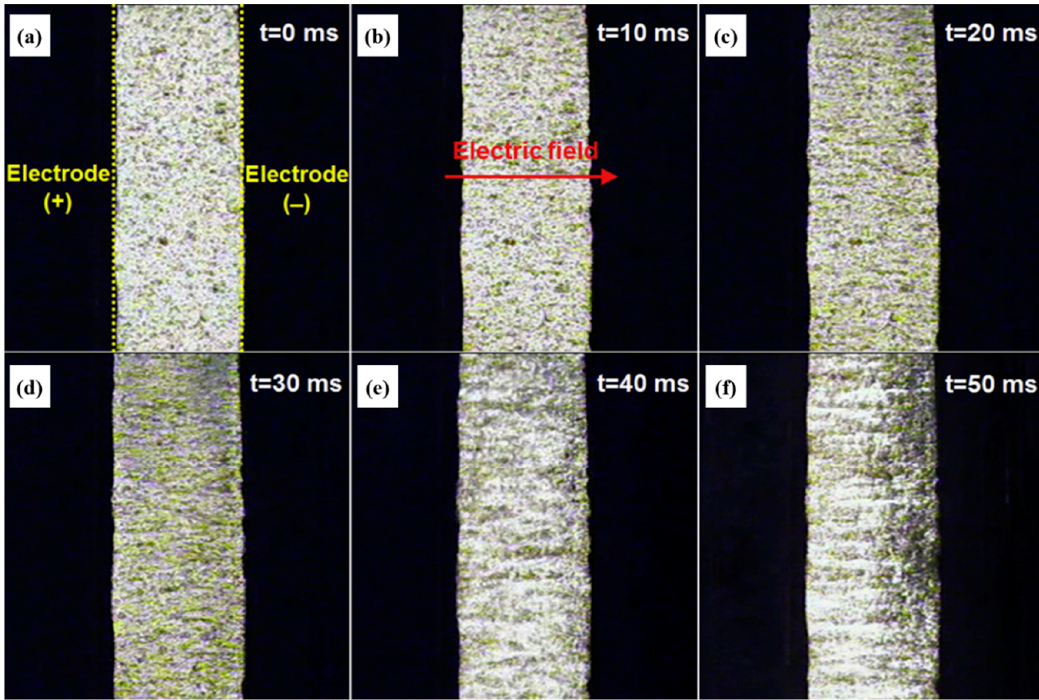
Figure 9. Optical microscope images of PANI/PSS-coated silica spheres dispersed in silicone oil (30 vol %) under applied electric field with different response time of ( a ) 0, ( b ) 10, ( c ) 20, ( d ) 30, ( e ) 40 and ( f ) 50 ms. The gap distance between the electrodes was adjusted to 1 mm (Lee et al. [70], © Elsevier, 2013).